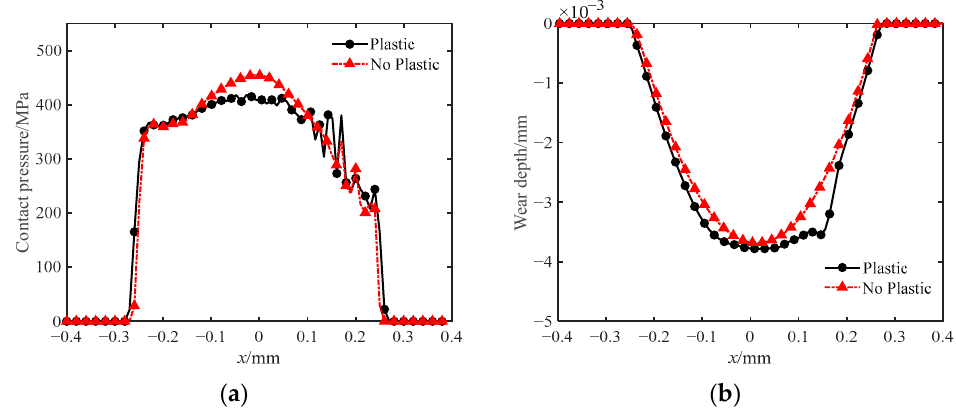
Figure 6. Effect of plastic deformation of materials on contact pressure and wear depth. ( a ) Contact pressure; ( b ) wear depth.